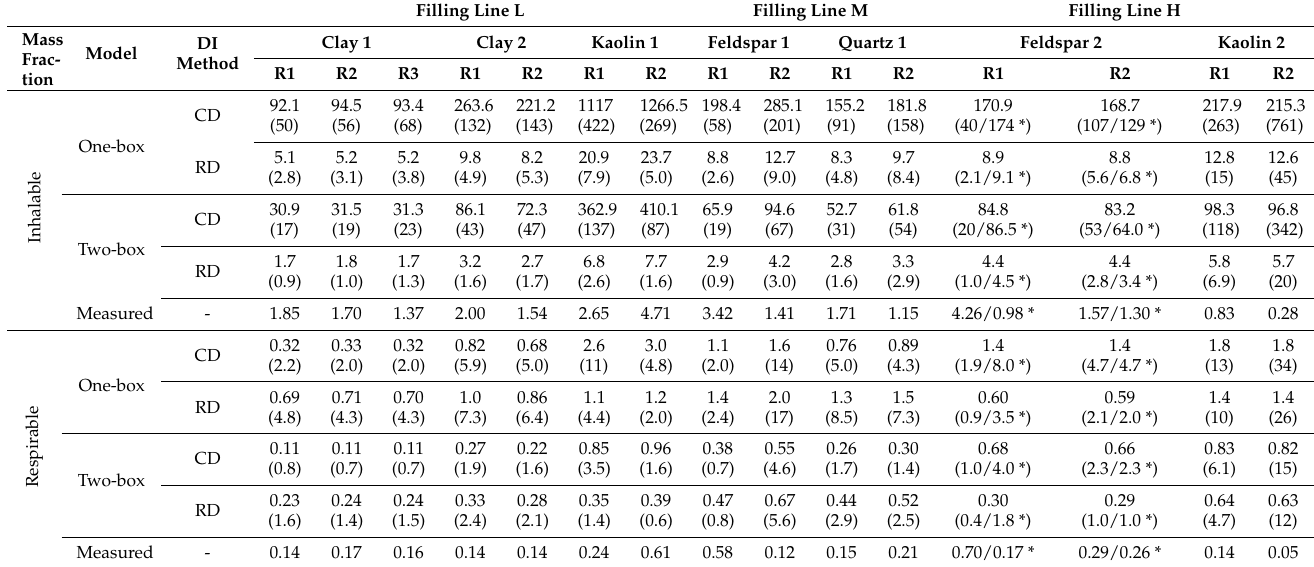
Table 2. Measured stationary concentrations at the worker area, and one- and two-box modelling results for inhalable and respirable mass fractions (mg m − 3 ), and for CD and RD dustiness index. Ratio modelled/measured shown in brackets. Modelling parameters: LEV and β fixed at 70% and 5 m 3 min − 1 , respectively. Rn: number of replicates for each material. * Not considering unexpected